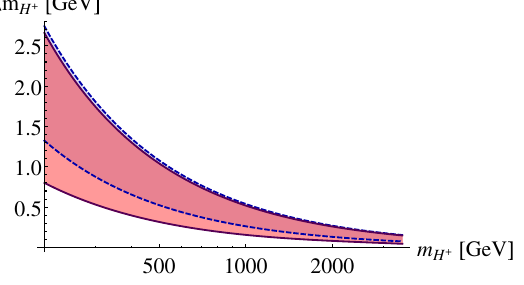
Fig. 11 Dependence of the sizes of the uncertainty bands (cid:16) m H + on the charged Higgs mass when driven by M 12 . The left (right) plot shows the size of (cid:16) m H + generated by the 1 σ top (bottom) quark uncertainty.